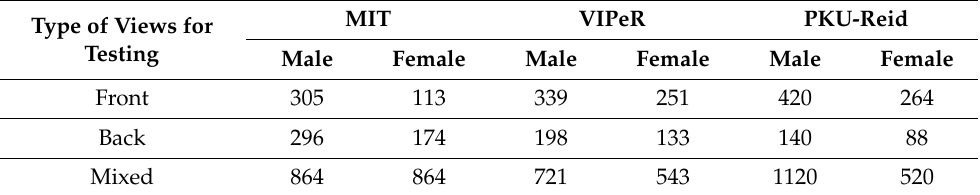
Table 3. View-based sample in MIT, VIPER, PKU-Reid, and PETA datasets used for testing of proposed model.